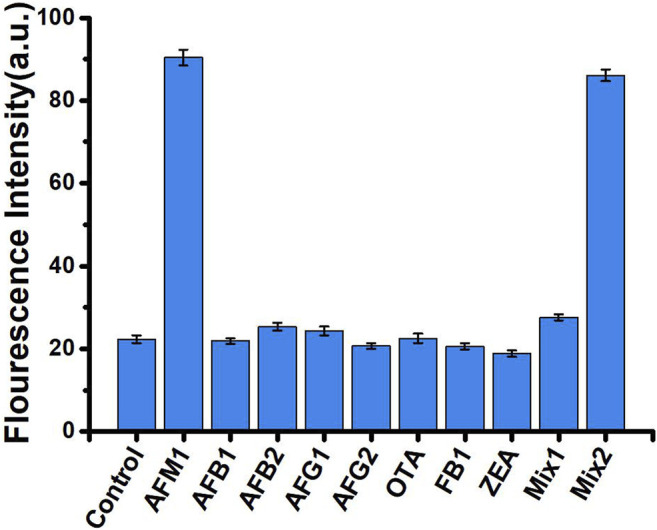
Fluorescence intensity in the absence (control) and presence of 40 ng/mL mycotoxins: AFM1, AFB1, AFB2, AFG1, AFG2, OTA, ZEN, and FB1, MIX1 (AFB1, AFB2, AFG1, AFG2, OTA, ZEN, and FB1), and MIX2 (AFM1, AFB1, AFB2, AFG1, AFG2, OTA, ZEN, and FB1). Excitation/emission λex/λem = 495/520 nm. Reaction conditions: 10 nM AFM1 aptamer and 20 nm cDNA in Tris-HCl buffer (10 mM, pH 7.0).